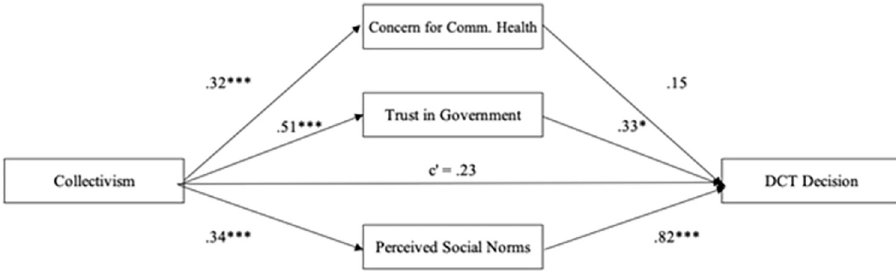
Fig 1. Mediation model for DCT decision. The relationship between collectivism and decision to opt-in to DCT as mediated by concern for community health, perceived social norms, and trust in government. Numbers are standardized regression coefficients.